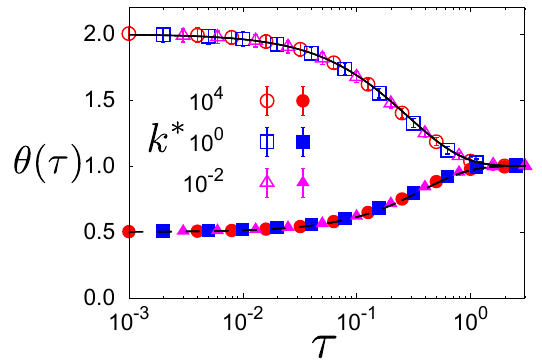
Figure 3. Time evolutions of the dimensionless temperature from the theory (20a) for θ 0 = 2 (solid line) and 0 . 5 (dashed line) when we choose the softness of the particles as k ∗ ≡ k / ( m ζ 2 10 4 , 10 0 , and 10 − 2 . Here, the di ff erence between lines is almost invisible. The symbols represent the simulation results. We note that the error bars are smaller than the